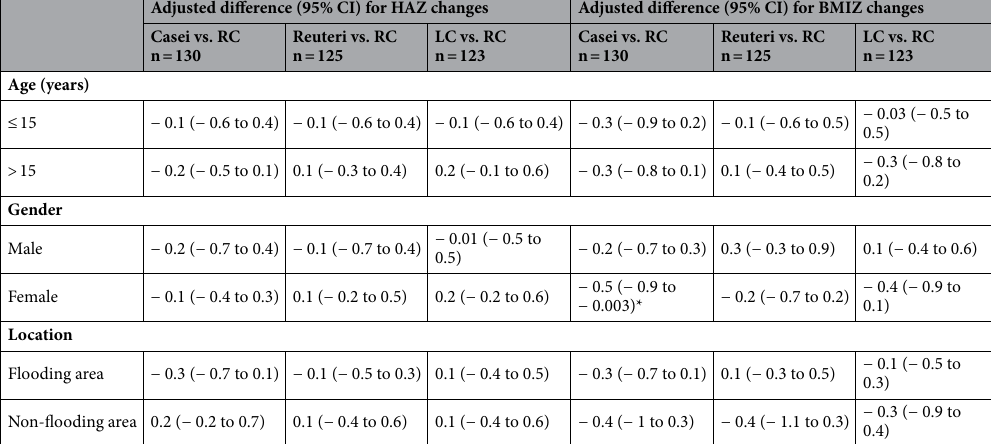
Adjusted difference (95% CI) for HAZ